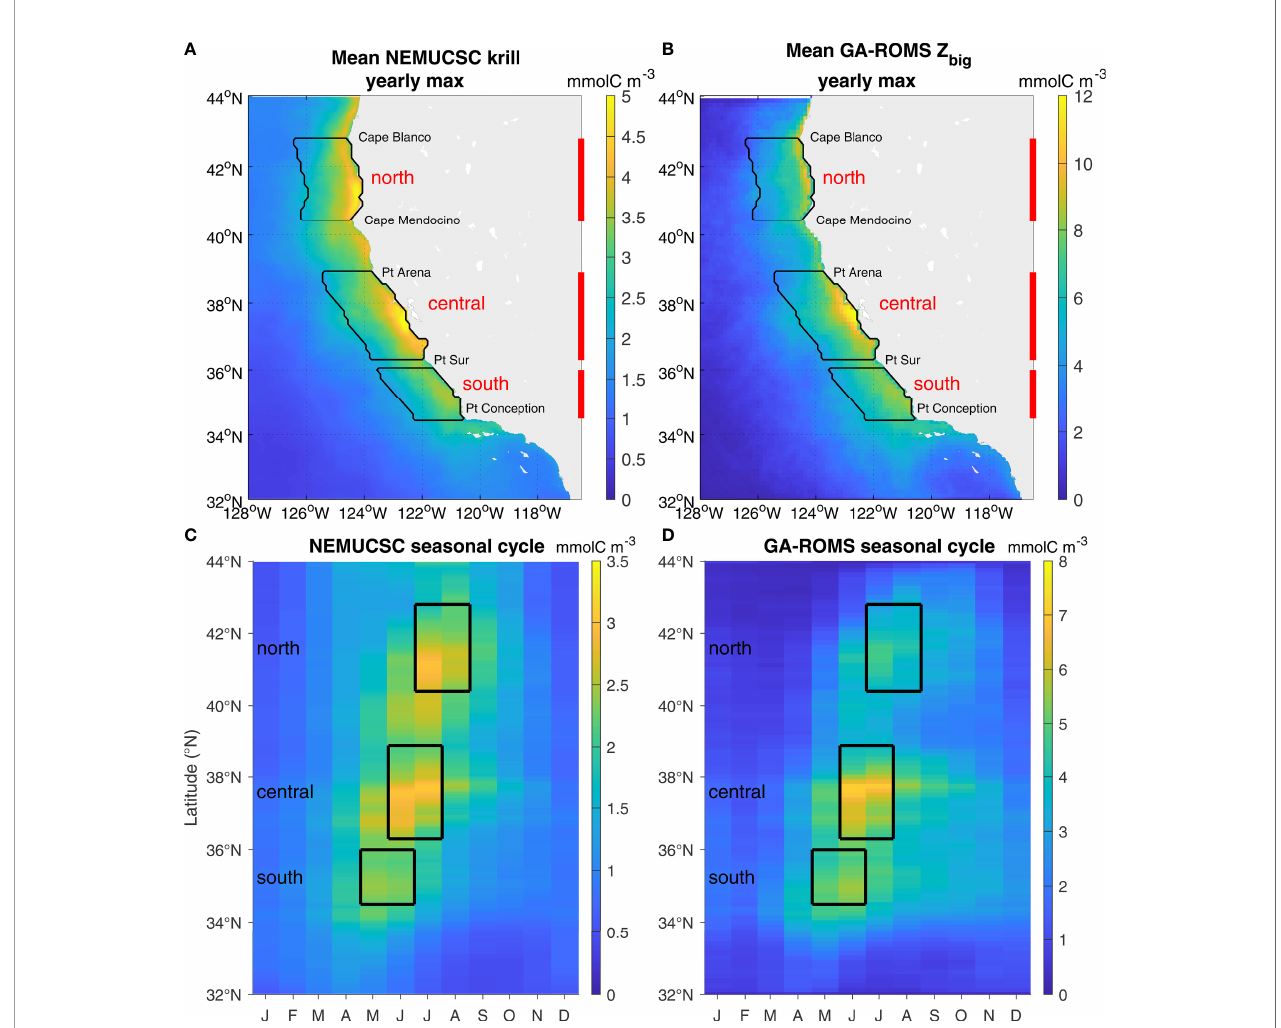
FIGURE 3 | Seasonal distribution of krill hotspots in NEMUCSC and GA-ROMS. (A , B) Spatial patterns: maximum yearly values computed at each grid cell each year, and averaged over all years (1990-2010 time period) for NEMUCSC (A) and GA-ROMS (B) . The three main hotspots are contoured in black (north 40.4-42.8°N between Cape Mendocino and Cape Blanco, central 36.3-38.9°N between Point Sur and Point Arena, south 34.5-36°N between Point Conception and Lopez Point, up to 150 km offshore). (C , D) Monthly climatological values averaged within the 150 km coastal band for NEMUCSC (C) and GA-ROMS (D) . Black boxes indicate the latitudinal range and peak months of hotspots used to compute the time series presented in Figure 4